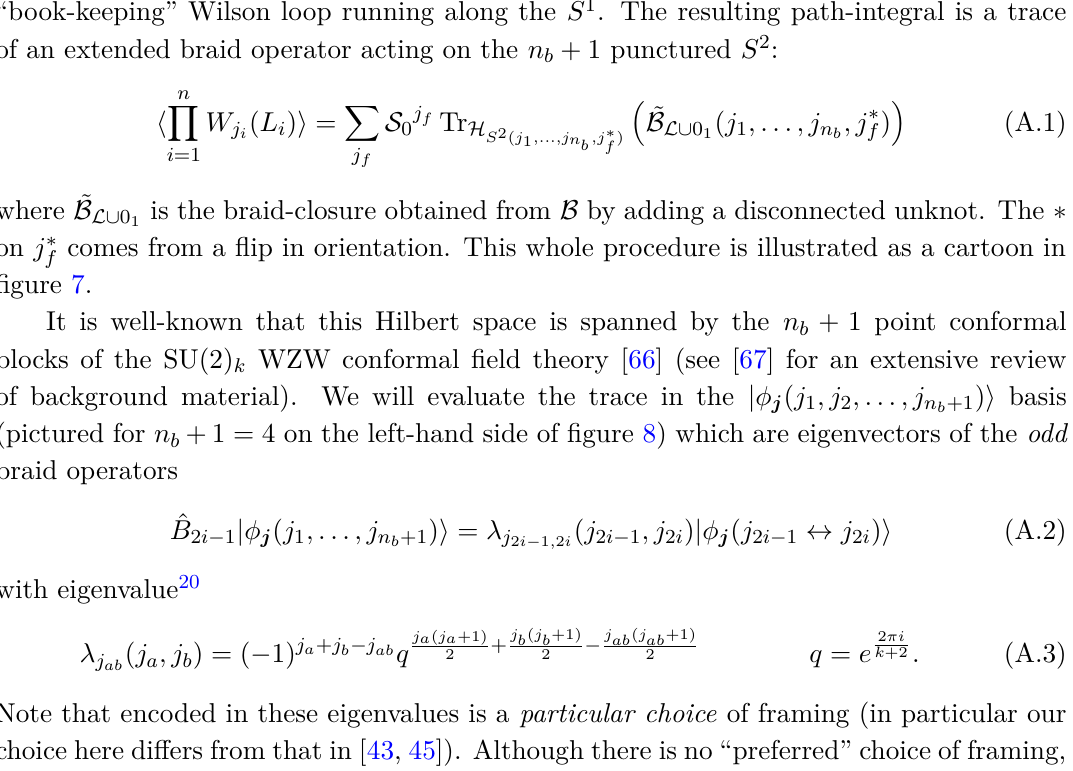
, book-keeps the S-matrix f